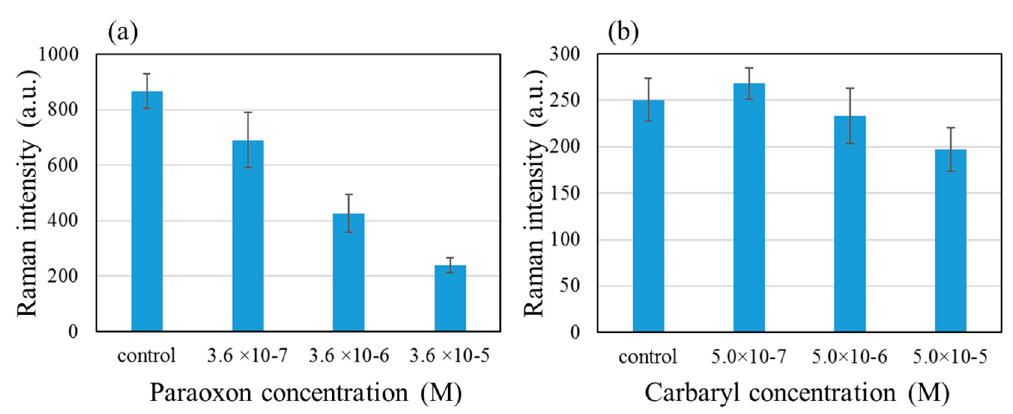
ff ects of ( a ) paraoxon and ( b ) carbaryl on the 768 cm − 1 peak intensity of Figure 7. Inhibitory effects of ( a ) paraoxon and ( b ) carbaryl on the 768 cm − 1 peak intensity of TC. Figure 7. Inhibitory e